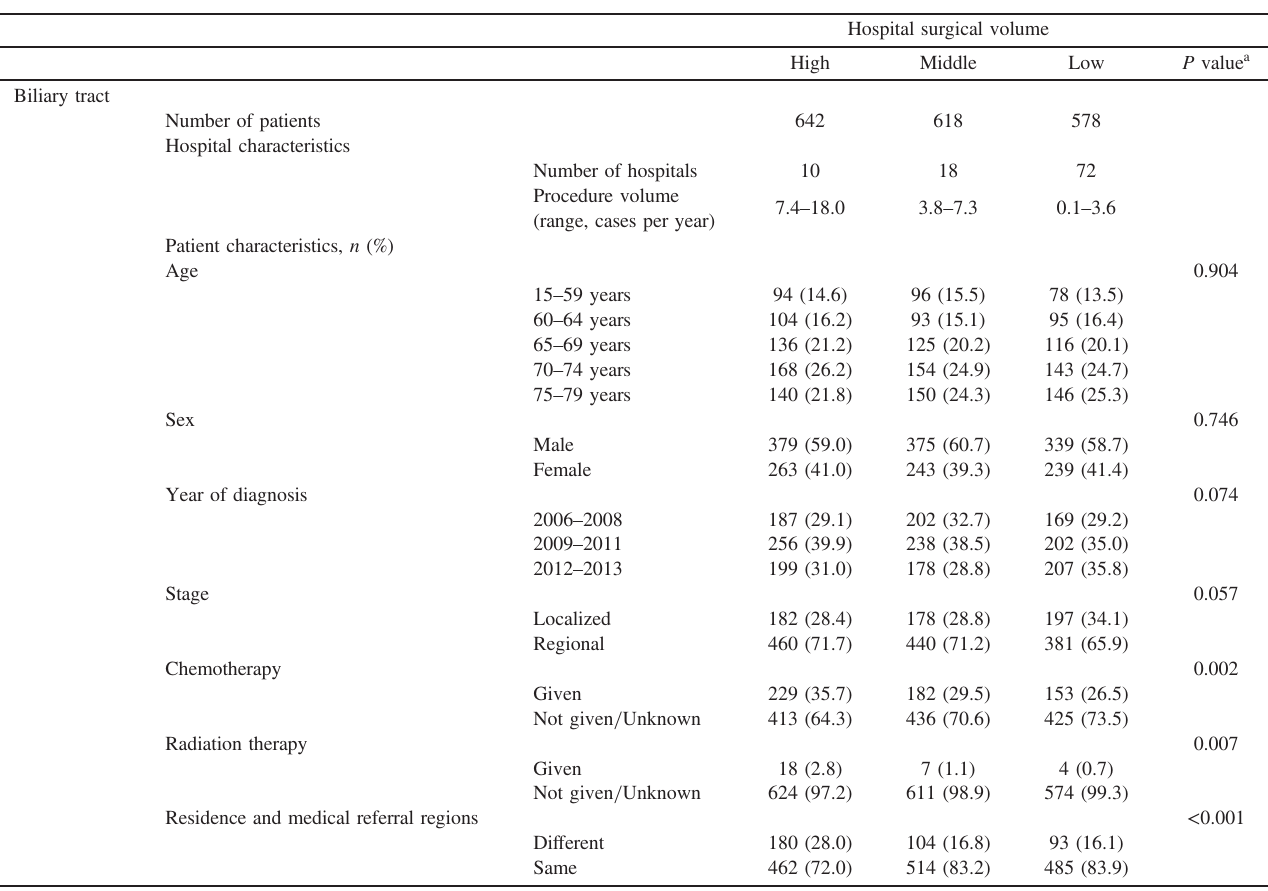
Table 2. Characteristics of biliary tract cancer patients undergoing curative surgery at high-, middle-, and low-volume hospitals, based on data from the 2006 – 2013 Osaka Cancer Registry Database ( n =